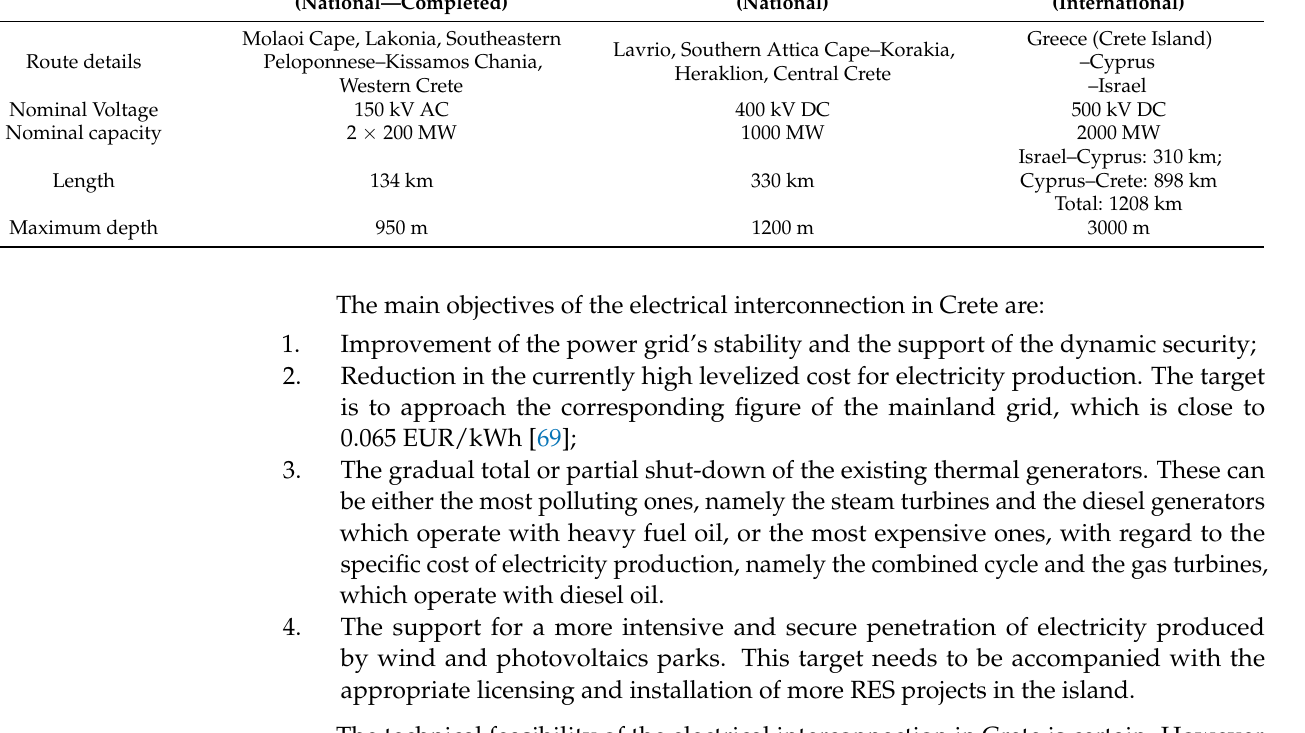
Table 4. Technical characteristics of the planned electrical interconnections of Crete with the mainland grids of Greece (IPTO 1 and IPTO 2) and the international Euroasia with Cyprus and Israel.